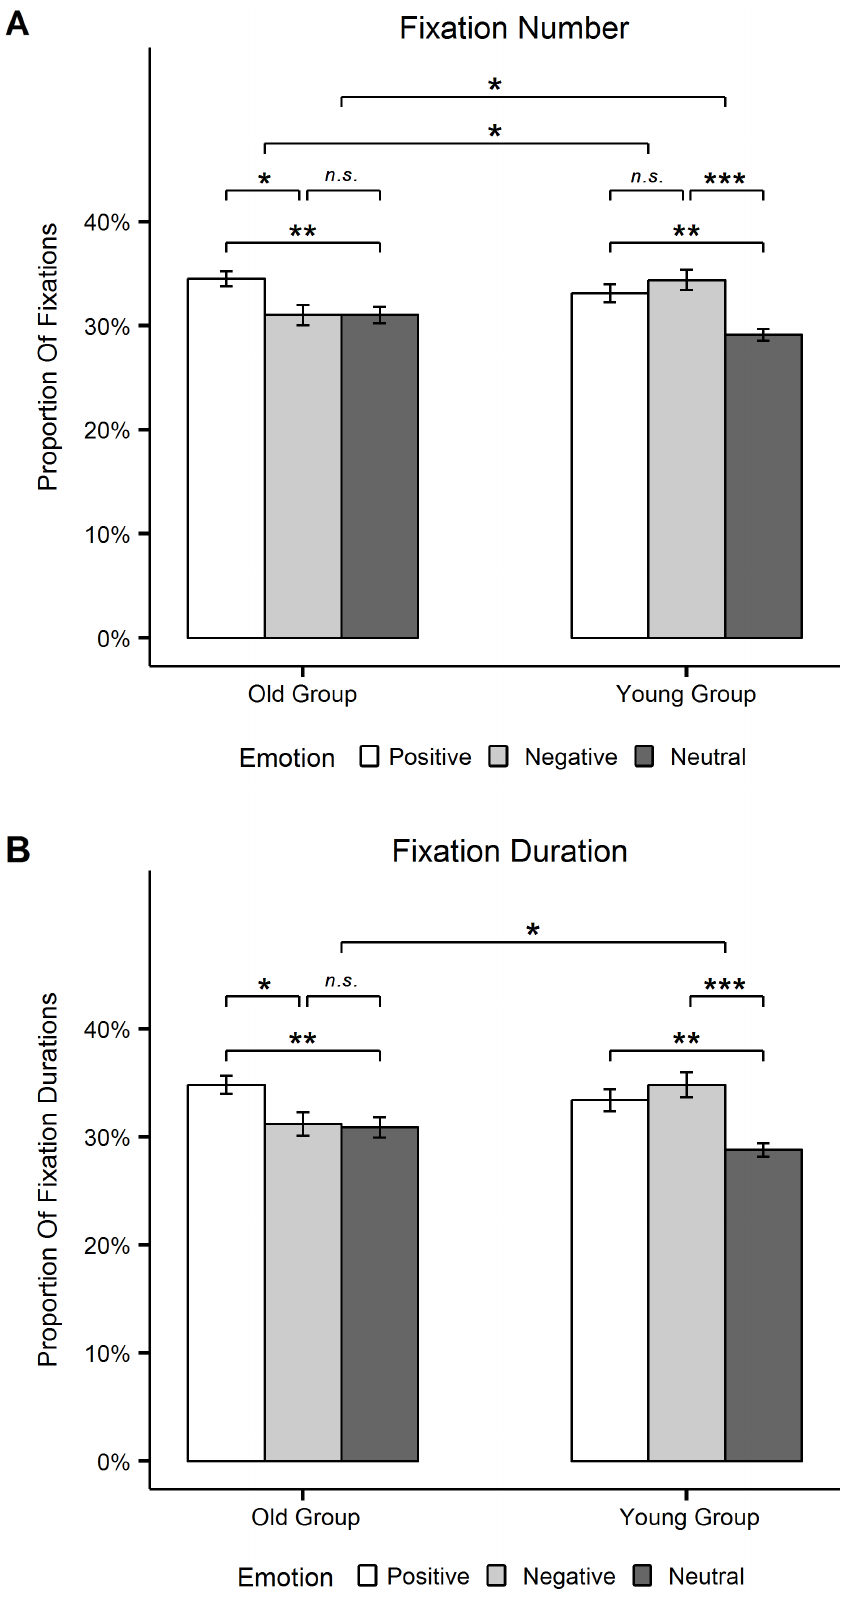
Figure 4. Post-hoc eyetracking results of emotion and emotion x group effects. Proportions of fixations (A) and fixation durations (B) on positive, negative and neutral stimuli aggregated across own-age and other-age stimuli, plotted separately for each age-group; Error bars represent standard errors of the mean. * p , .05, ** p , .01, *** p , .01, n.s. =not significant. doi:10.1371/journal.pone.0104180.g004 PLOS ONE |